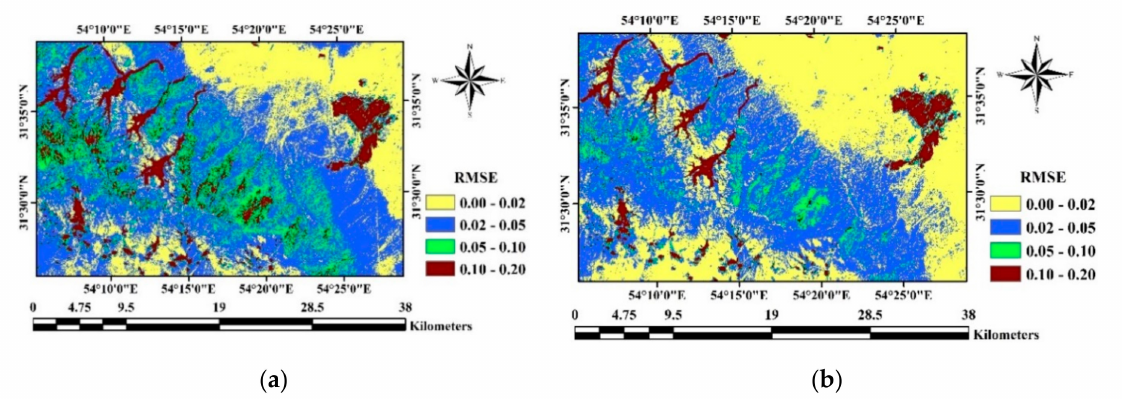
Figure 10. RMSE map between the original and reconstructed time series using the HANTS algorithm ( a ) and the M-SSA algorithm ( b